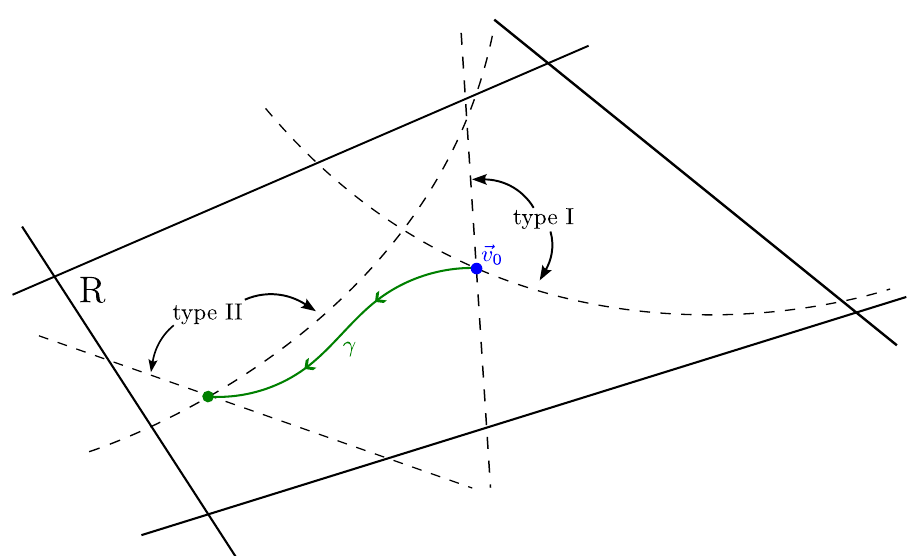
Figure 2. Graphical representation of the kinematic region R which is bounded by the solid black lines. The dashed lines represent singular hypersurfaces on which some of the letters diverge. To fix the boundary constants, we start at some point ~v and impose cancellation of all singularities in the 0 PDE matrix at this point (which we call type I singularities). Then, we set up one-parameter paths labelled by γ that lead to all other singular hypersurfaces. Imposing cancellation of divergencies at the end-points of the path (which we call type II singularities) further restricts the boundary